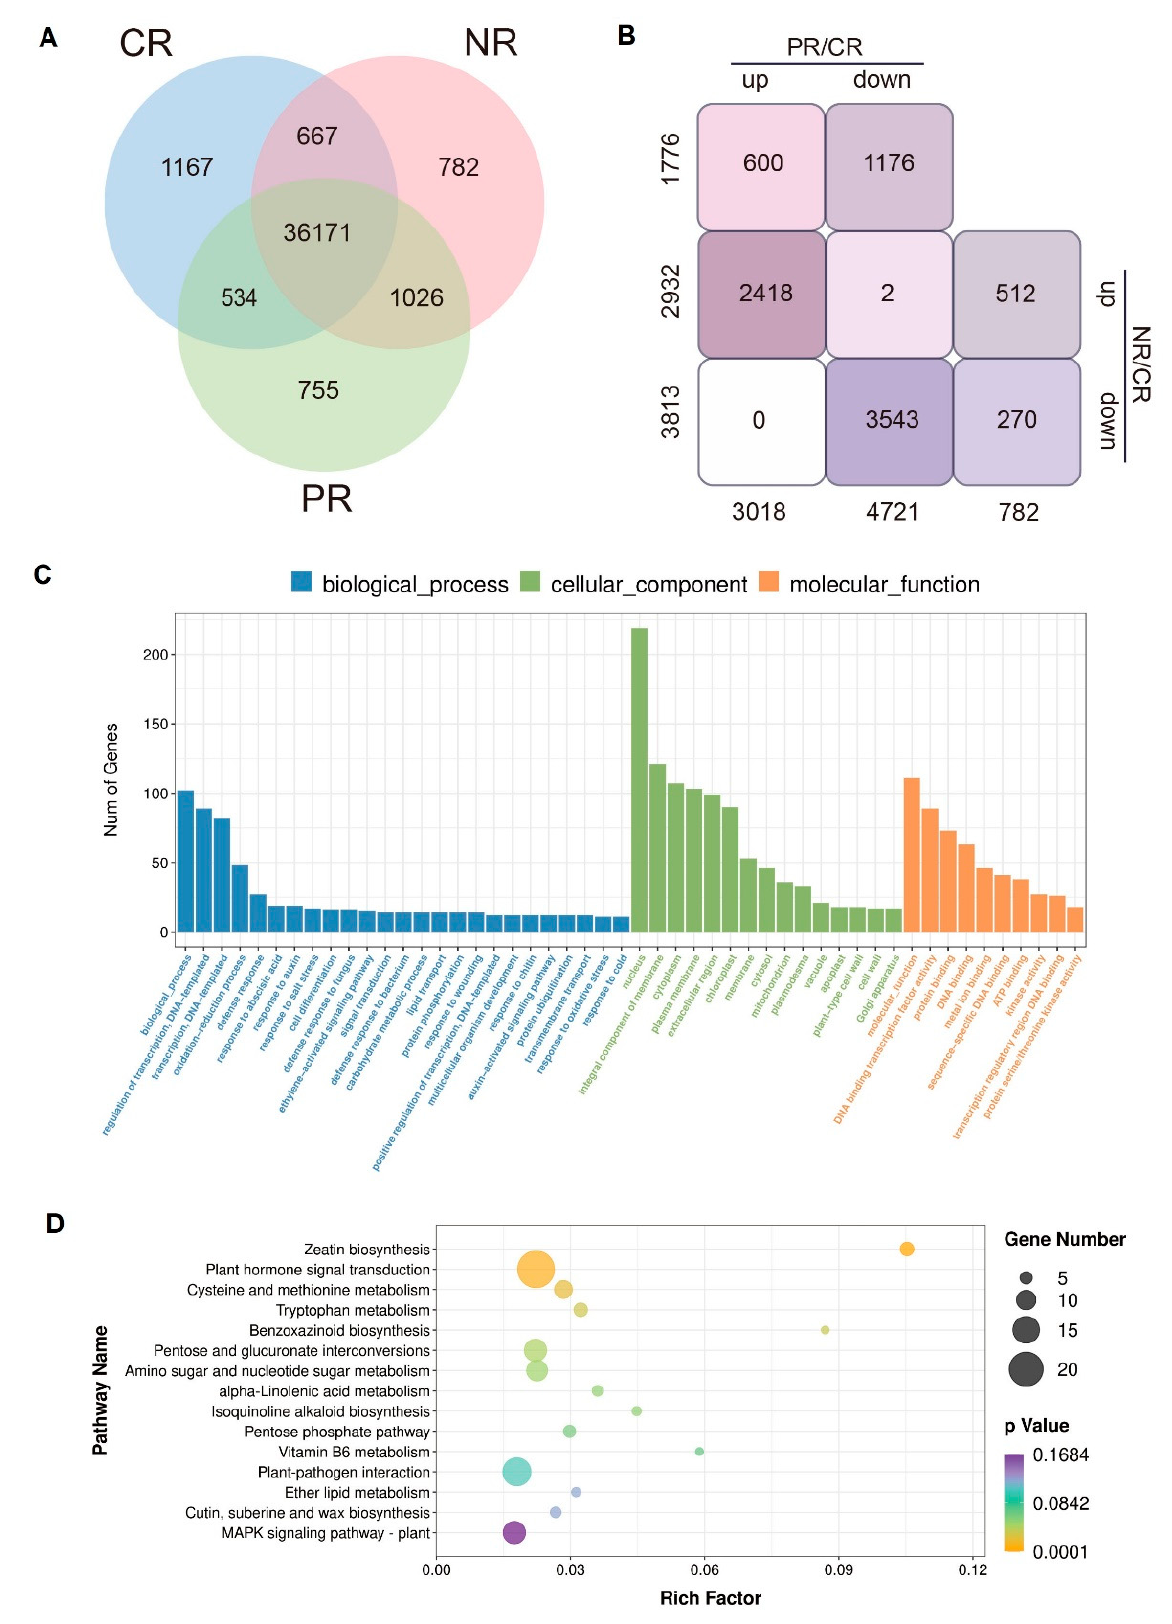
Figure 4. RNA sequencing analyses of broccoli seedlings with different treatments. ( A ) Venn diagram of the number of genes in CR, PR and NR samples. ( B ) Number of differentially expressed genes